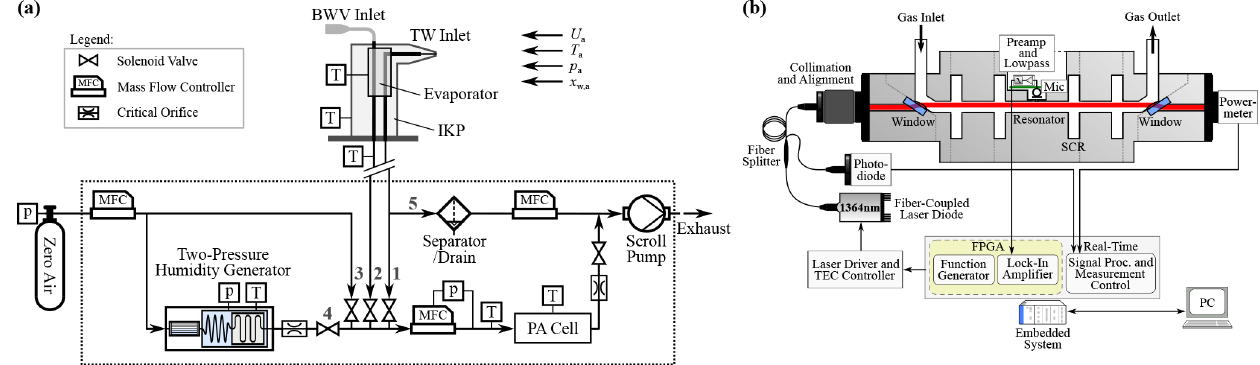
Figure 1. (a) Schematic of the instrument showing the isokinetic evaporator probe (IKP) and the measurement (PA cell), sampling, and calibration system (two-pressure humidity generator and zero air). Locations of temperature and pressure control are indicated by ( T ) and ( p ), respectively. Indicated numbers enumerate the individual flow paths. The rearward-facing BWV probe indicates the extension of the BWV inlet port not applied in this work. (b) Schematic of the photoacoustic cell together with the optical and the electronic setup, showing the control, data acquisition, and signal processing performed on the real-time embedded